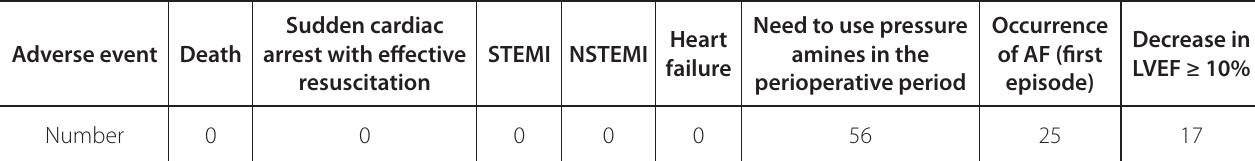
Table 3 . Occurrence of adverse events in the perioperative period.